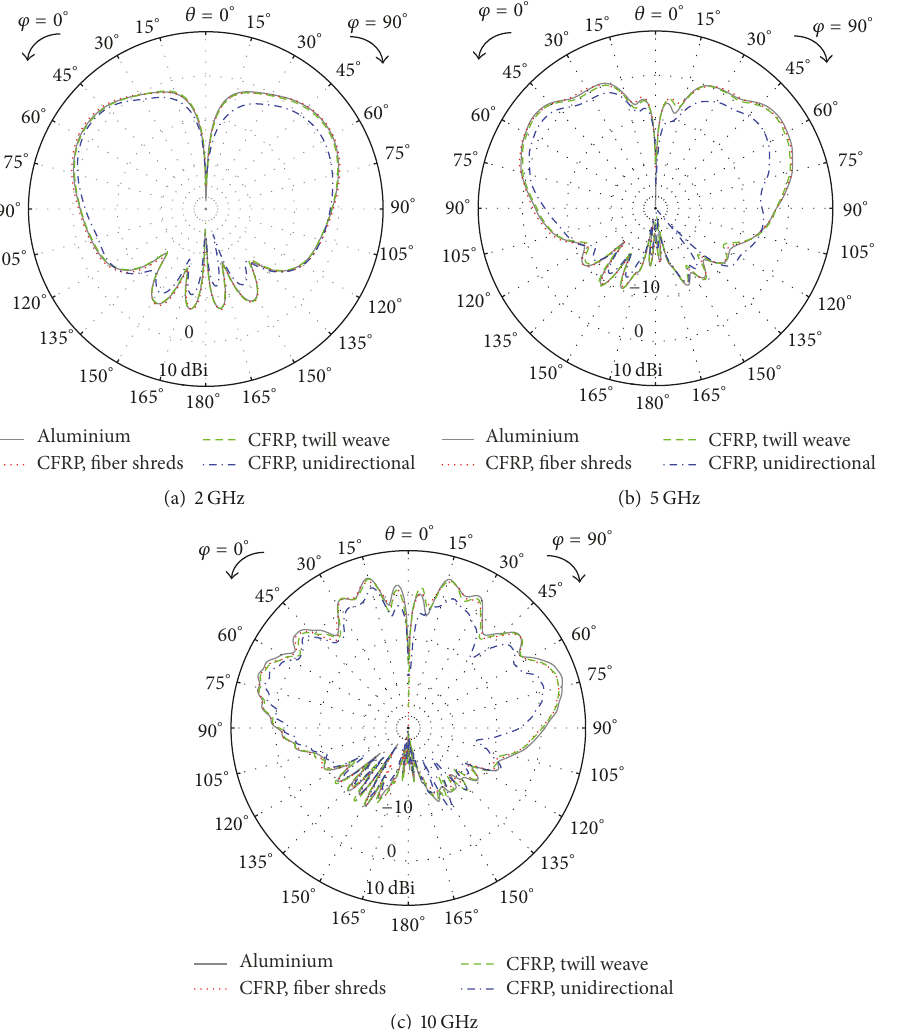
Figure 15: Vertical cuts of the gain patterns. Cuts for azimuthal angle 𝜑 = 0 ∘ and 𝜑 = 90 ∘ are shown on the left and right side, respectively (reprinted with permission from [35]; ©2017